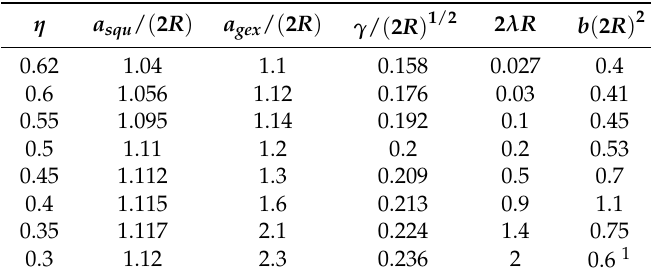
1 All the quantities are